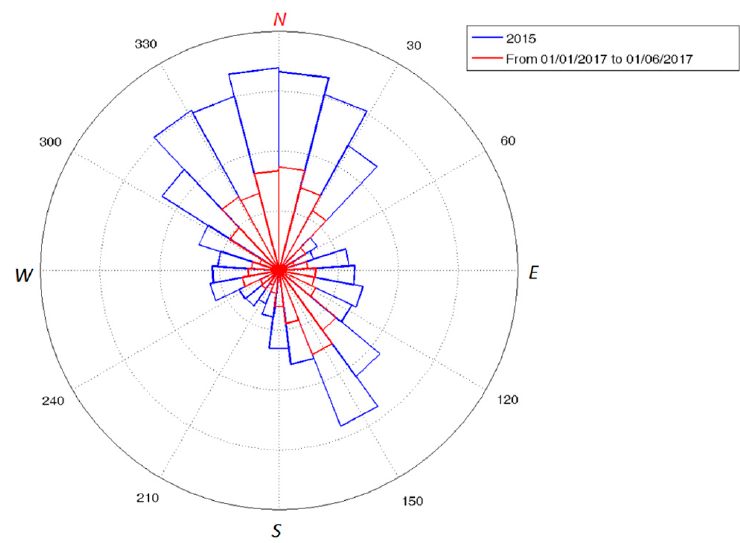
Figure 12. Density of the wind directions observed in the Cape Granitola site during the years 2015 and 2017, blue and red lines, respectively.